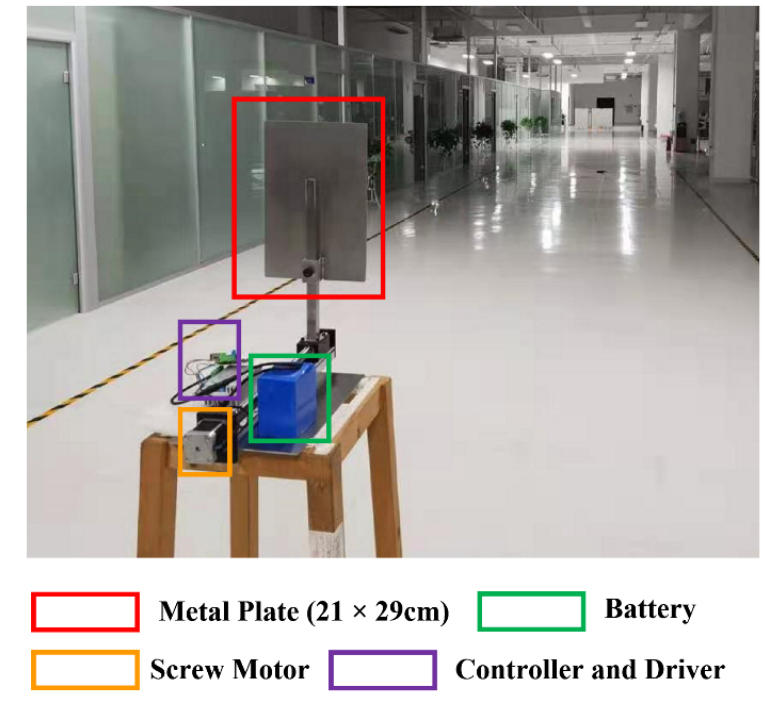
Figure 10. The metal plate beacon. Both the proposed “scanning operating mode” and the “FFT-based respiration de- tection method [29]” were applied to the collected radar echoes. The corresponding measurement results are shown in Table 3. The detection errors of the experiment for No. 1 and No. 2 radars are shown in Figure 11a,b, respectively. The blue error bars represent the detection errors of single-radar detection results via the “FFT-based respiration